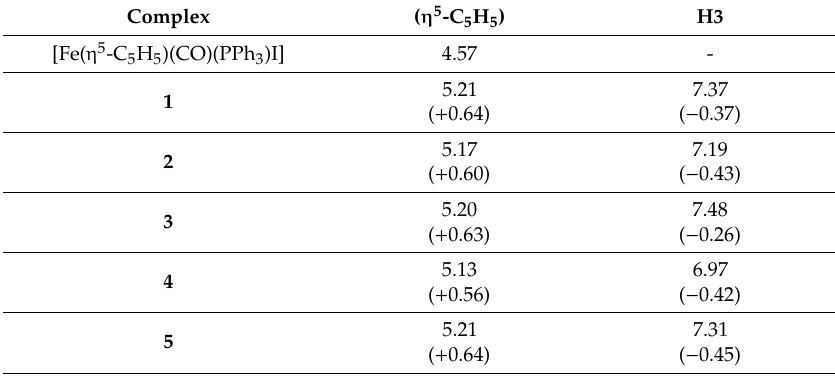
Table 1. Selected 1 H NMR chemical shifts (ppm). The spectra were obtained in acetone-d 6 . Values in brackets represent the di ff erences on H 3 between the coordinated and free nitrile.